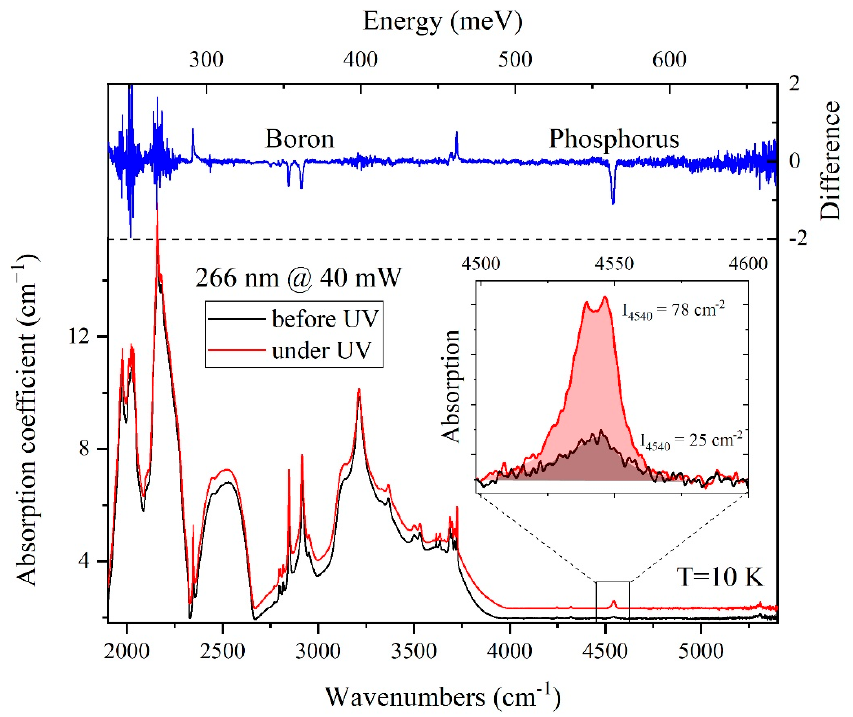
Figure 3. Absorption spectra of diamond Ph14N2 before (black) and during (red) laser irradiation with λ = 266 nm and power 40 mW; blue spectrum—subtraction of red spectrum from black one. The spectra are shifted for convenience.